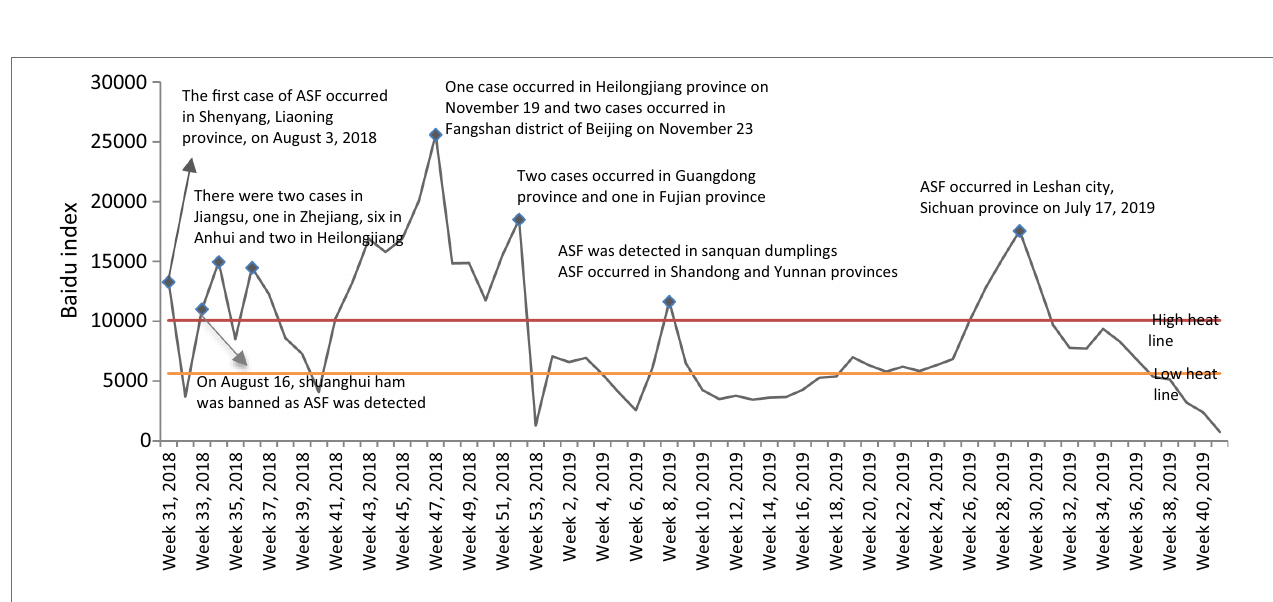
FIGURE 2 | Search-term interest during the ASF outbreak in China.